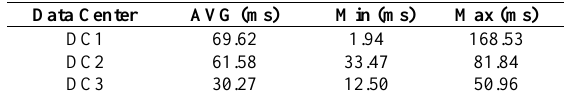
Table 2. Results from simulation using CloudAnalyst